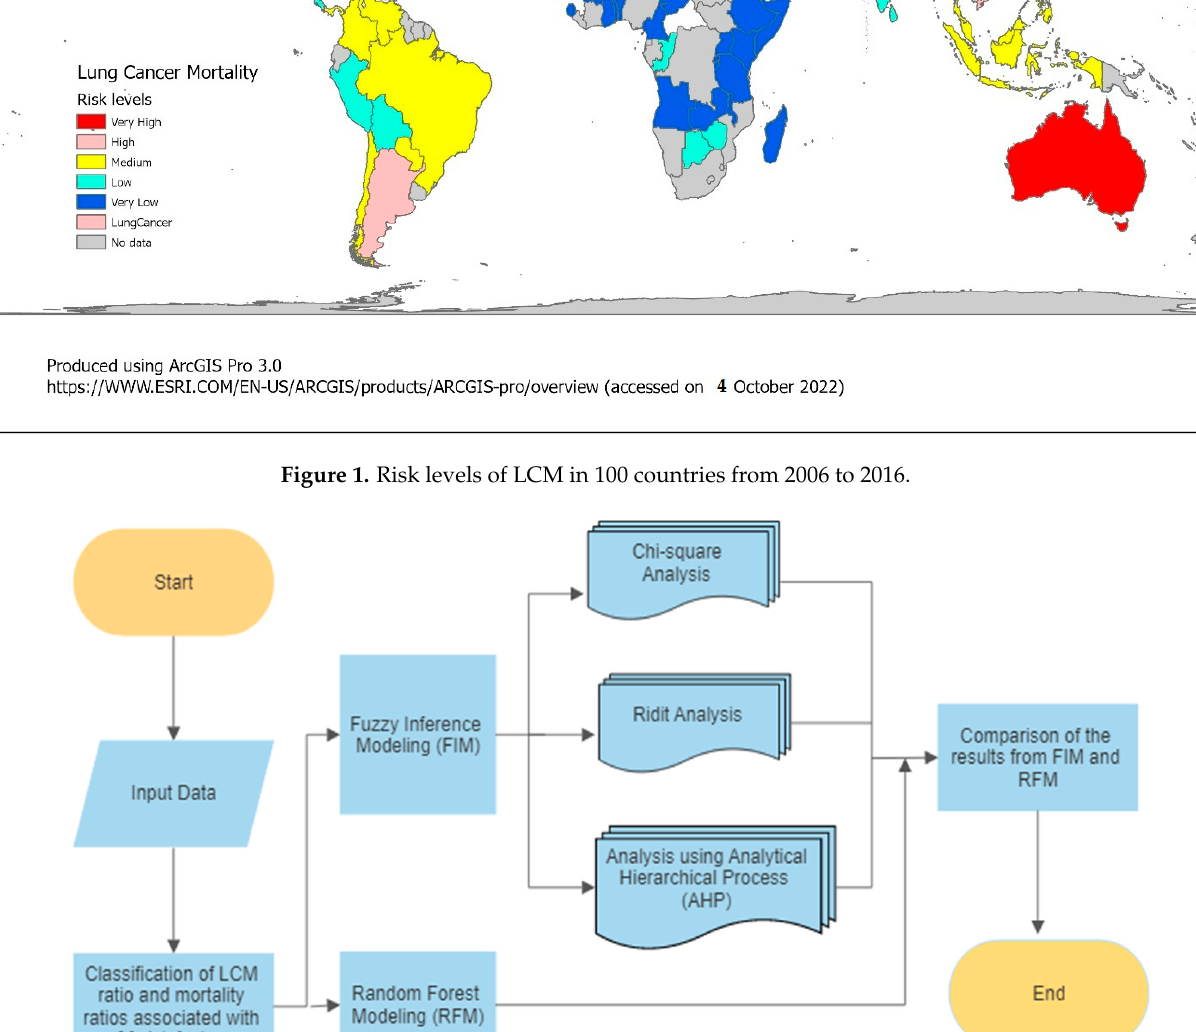
Figure 1. Risk levels of LCM in 100 countries from 2006 to 2016.